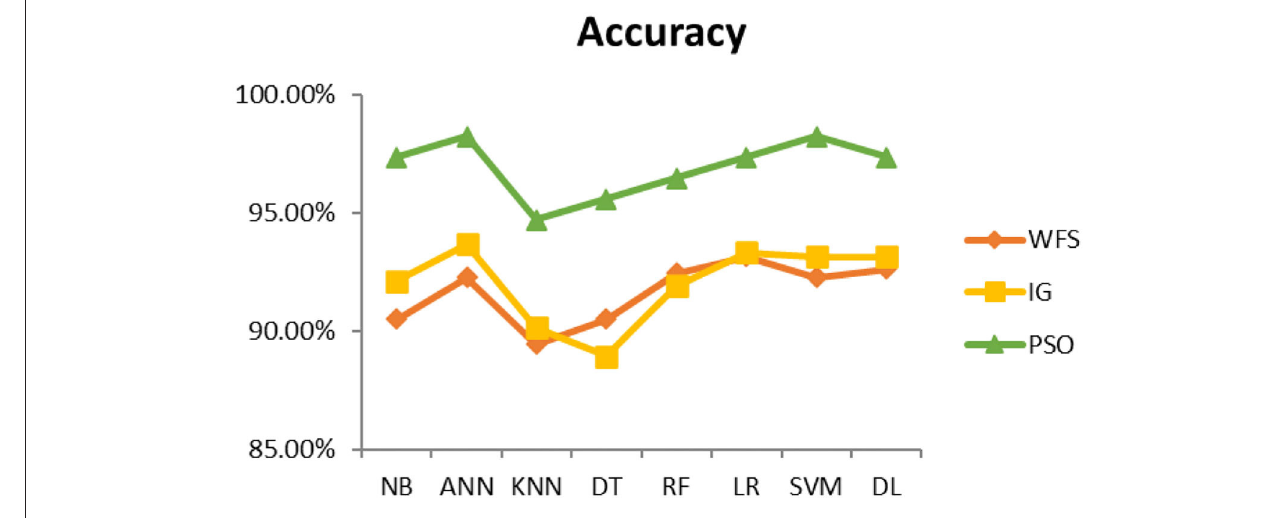
FIGURE 3 | Cancer diagnosis accuracy (dataset 1).